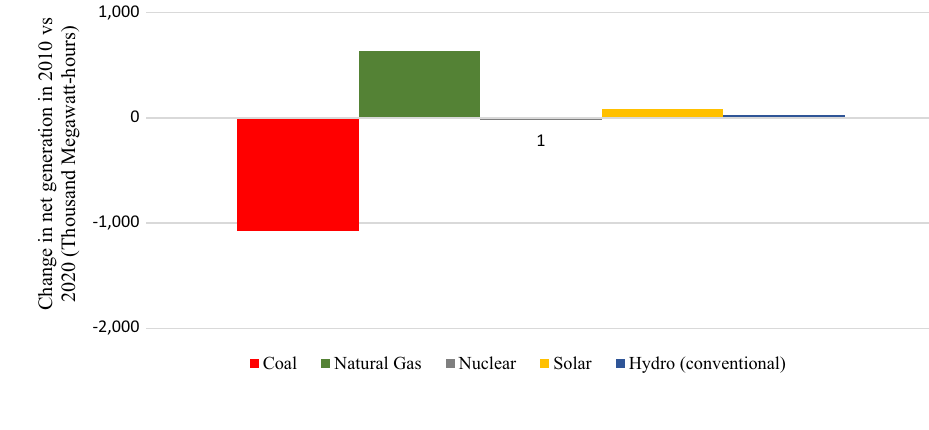
Fig. 2 Change in net electric- ity generation by source (2010